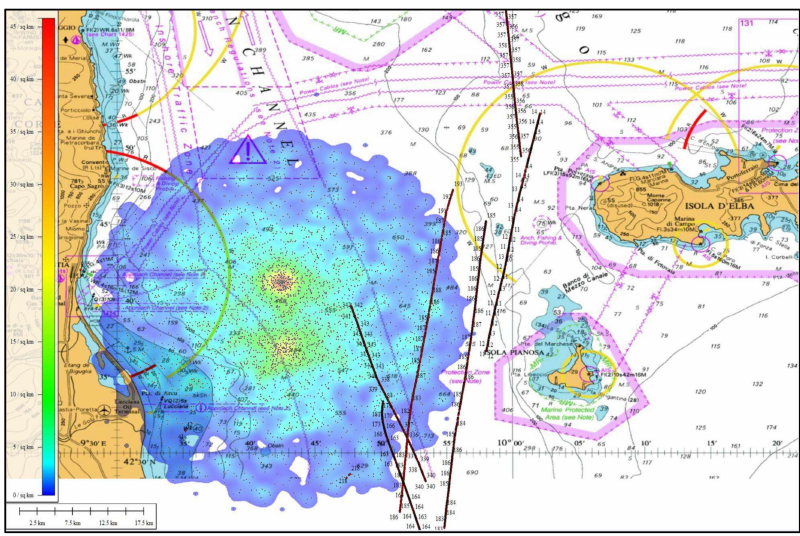
Figure 1. Automatic Identification System (AIS) spoofing analysis near Elba